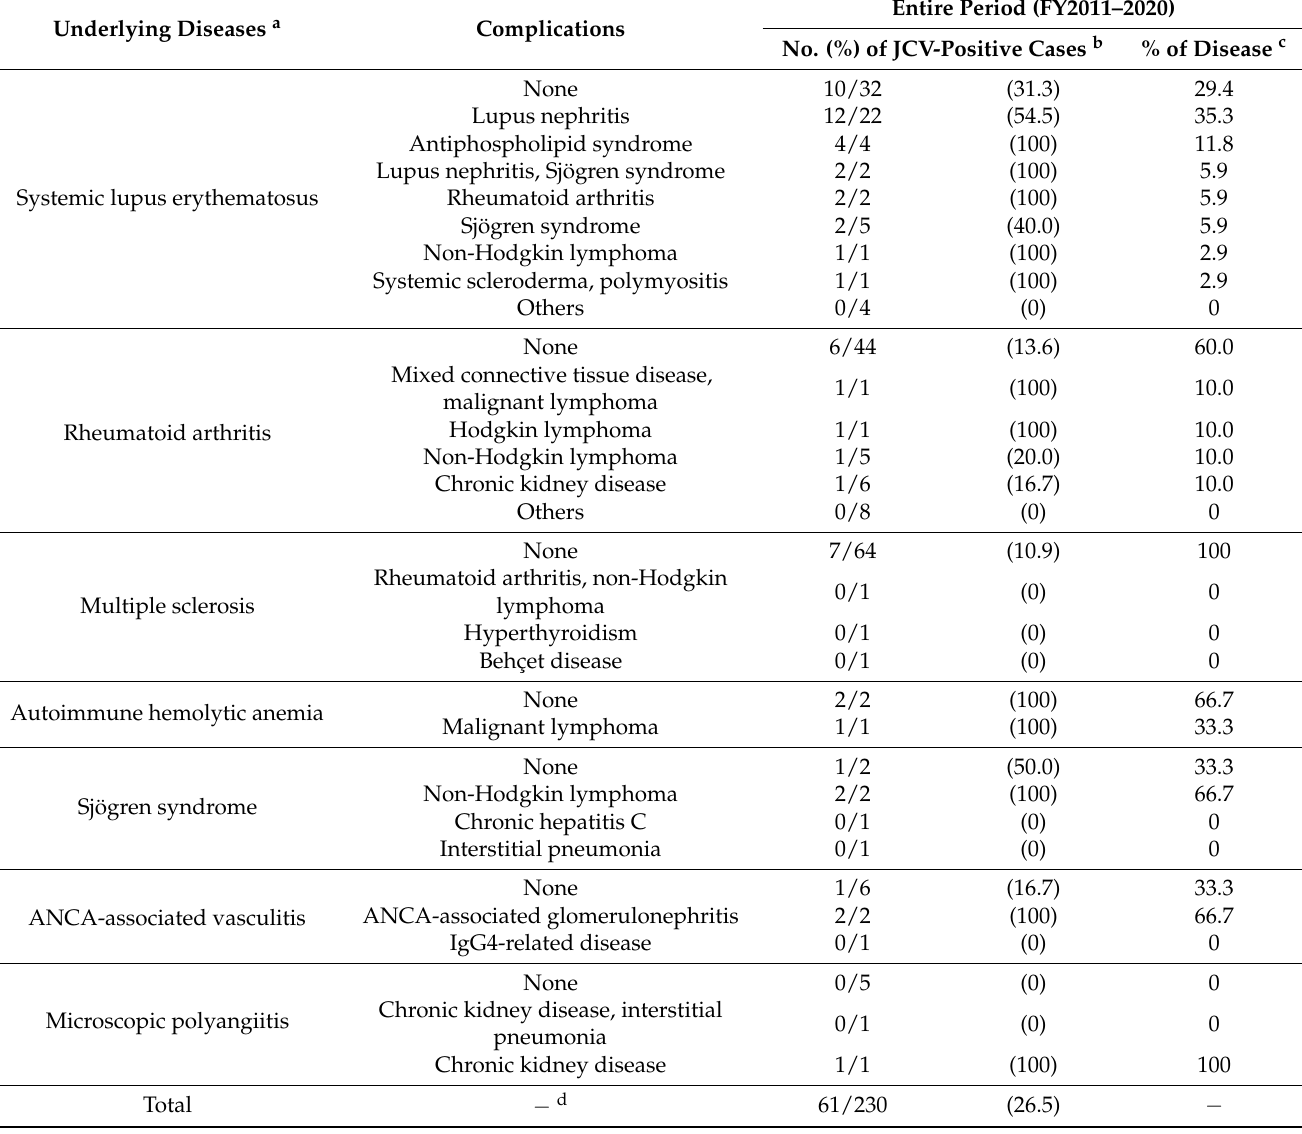
Table 4. Complications of autoimmune disorders in patients with JCV-positive